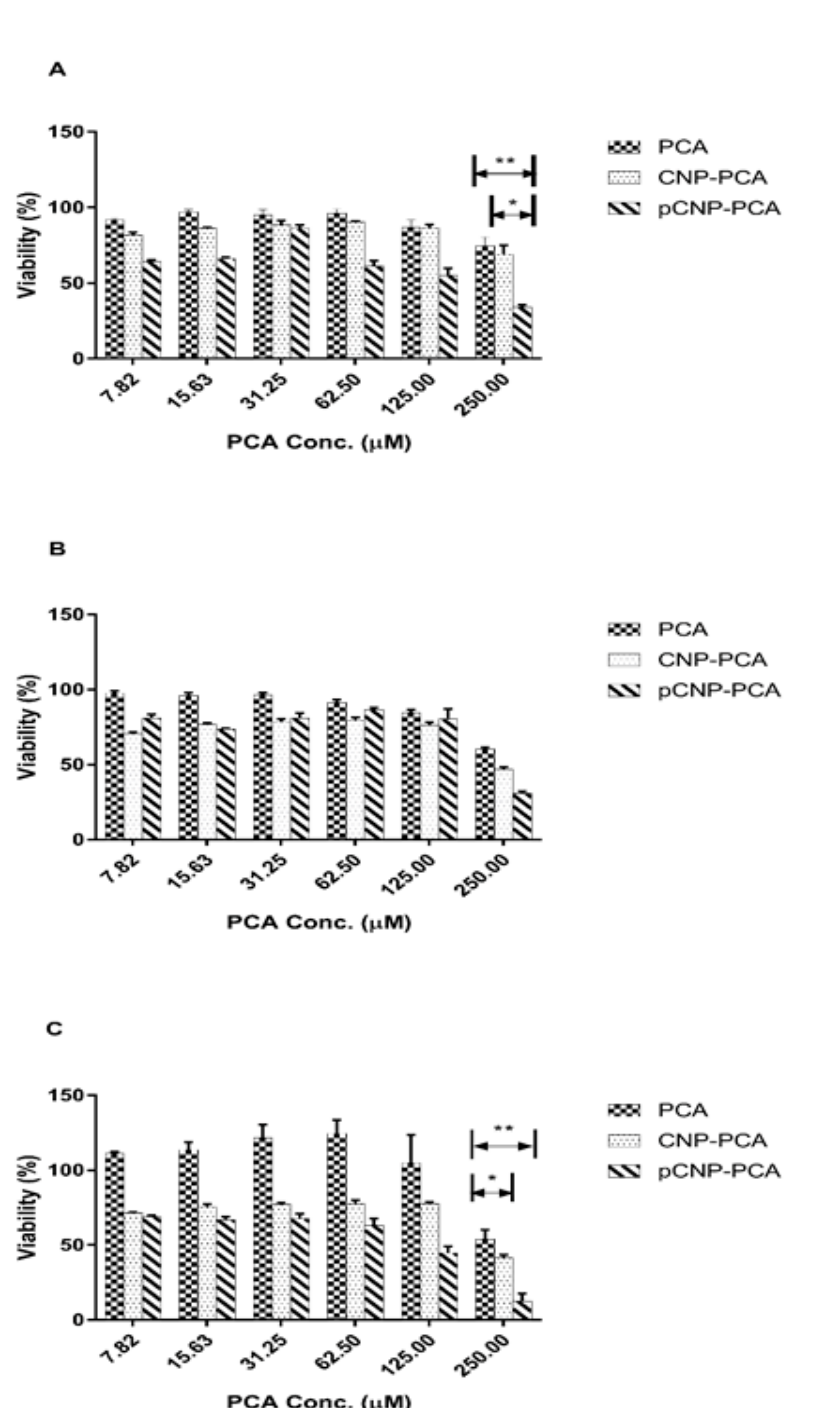
Figure 10. Cellular efficacy of PCA, CNP-PCA and pCNP-PCA at ( A ) 24 h post-treatment, ( B ) 48 h post-treatment and ( C ) 72 h post-treatment on A549 cell line. Data are presented as mean ± SEM from three independent experiment replicates. One-way ANOVA was performed and the significance was indicated by * = p < 0.05 and ** = p < 0.01 for all three graphs.